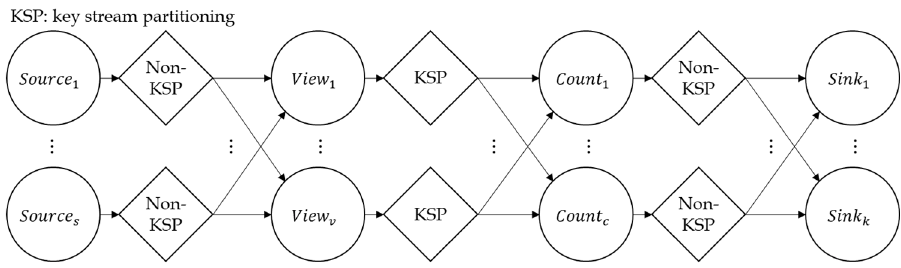
Figure 11. Real-world workload application: page view count.